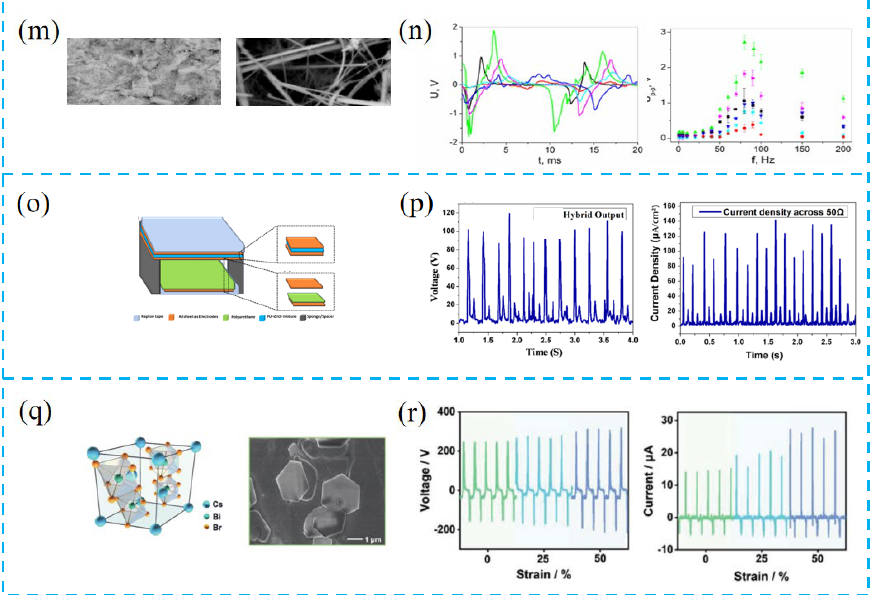
Figure 5. ( a ) SEM and AFM images of ZnO-PVDF film and schematic diagram of PTCNG. ( b ) Rectified open-circuit voltage and short-circuit current density of PTCNG. ( c ) The circuit diagram of the PTCNG for lighting up LEDs and charging ability test of the PTCNG. ( d ) The output voltage, output current, and instantaneous power changes with the increasing load resistance for the PENG. ( e ) Perovskite crystal structure of KNN and SEM image of KNN powder. ( f ) Output voltage response and output current response of the EF-attached PTCNG at a 240 BPM tapping frequency. ( g ) Photograph of the prepared BTO/PDMS composite film and cross-sectional SEM image of the composite film. ( h ) Output voltage under the three testing modes: hybrid, triboelectric, and piezoelectric. ( i ) Different views of 3D virtualization by SRXTM analysis of CS/BT-NRs 7 wt.% composite film, with an inset of the TEM image for BT-NRs. ( j ) Average maximum voltage output and average maximum current output with a tendency for varying amounts of BT-NRs fillers (0, 3, 7, 10, 12, and 15 wt.%) and composited films. ( k ) XRD pattern and the SEM image of the BTS particles (the inset shows its grain size distribution). ( l ) The open-circuit voltage and the short-circuit current of the HEH with different BTS particles’ content. ( m ) The SEM image of the SbSeI nanowire. ( n ) Voltage signals recorded for shaker tip excitation at an 80 Hz frequency and spectra of peak-to-peak voltage generated by driving the shaker with a rectangular signal for an unloaded device. ( o ) The schematic of the proposed PTCNG. ( p ) Rectified output voltage and current density of PTCNG. ( q ) Unit cell crystal structures of Cs3Bi2Br9 and SEM images of pure Cs3Bi2Br9 thin film. ( r ) The output voltage and current of LPPS-NFC-based TPENG under 0%, 25%, and 50% strain.